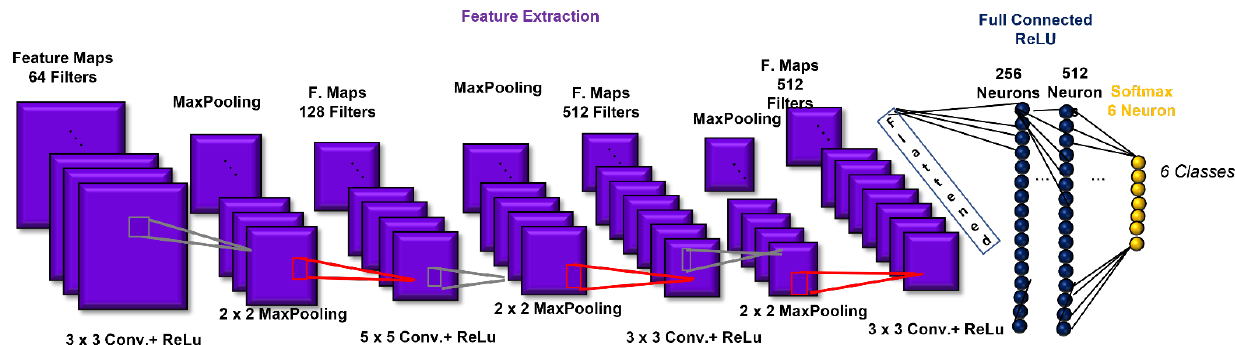
Figure 5. Convolutional-neural-network (CNN) architecture, which includes the structure of the implemented convolution building block.